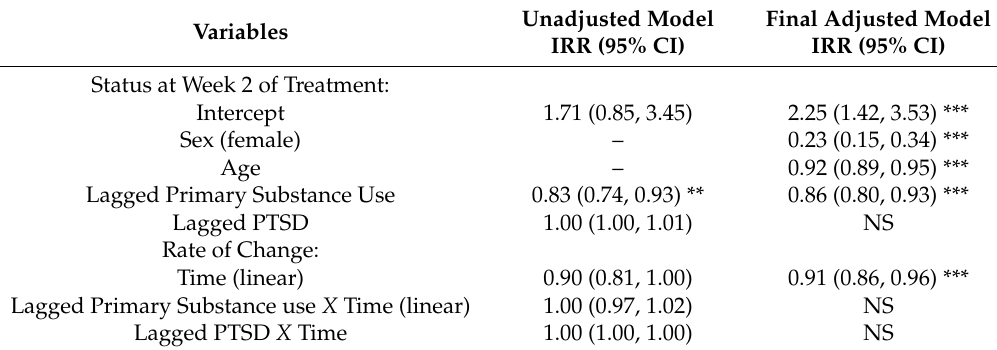
Table 4. Exponentiated regression coefficients for models examining the association of cross-lagged primary substance use on weekly cannabis